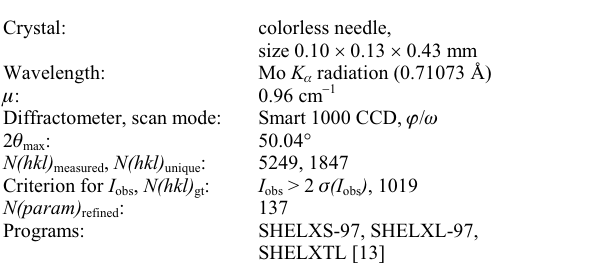
Table 1. Data collection and